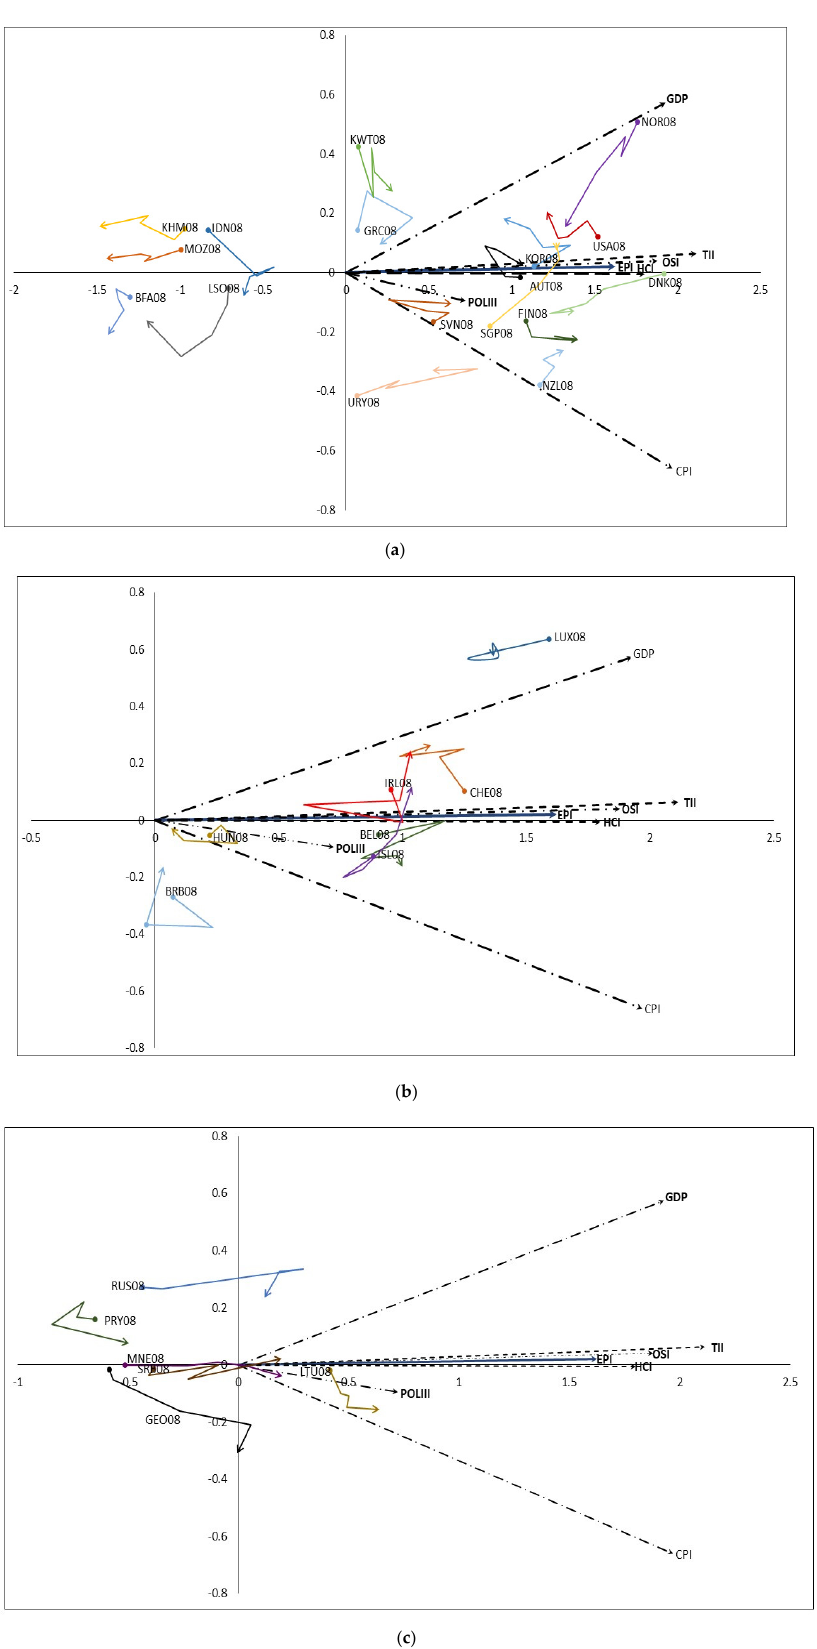
Figure 5. The trajectory of the countries by e - participation index: ( a ) according to their national sit- uation; ( b ) below; ( c ) (Bowl).